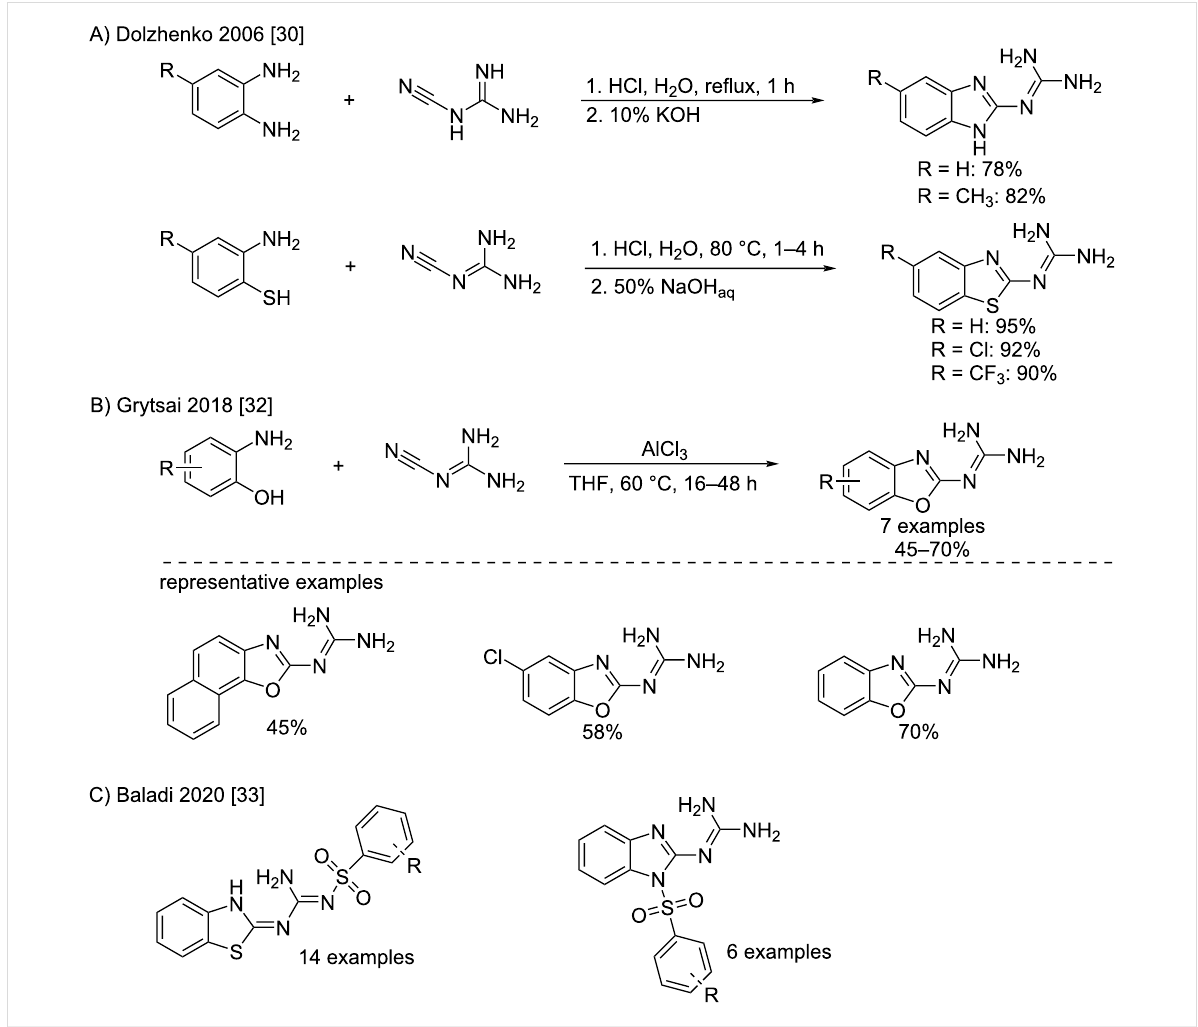
Scheme 11: Synthesis of 2-guanidinobenzazoles by addition of ortho -substituted anilines to cyanoguanidine [30,32] and related sulfonylguanidine compounds [33].